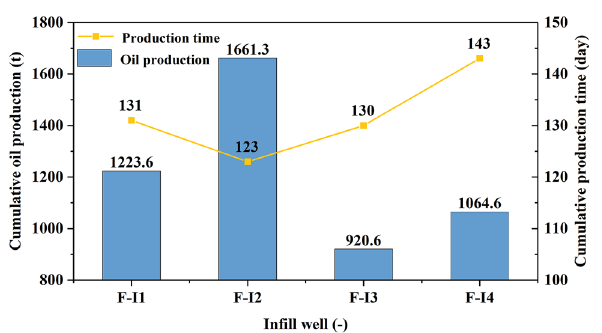
Fig. 23 Cumulative oil production of the four infill wells (F